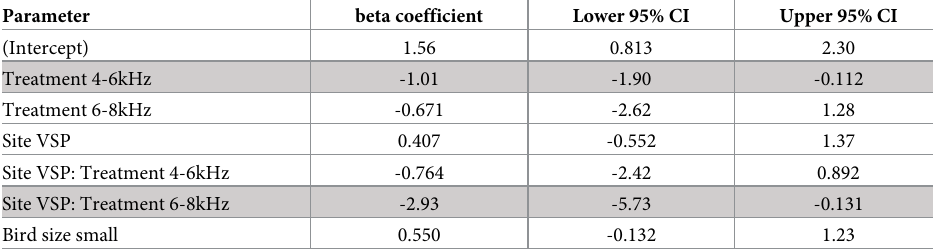
Table 5. Within-flight change in velocity model-averaged parameter